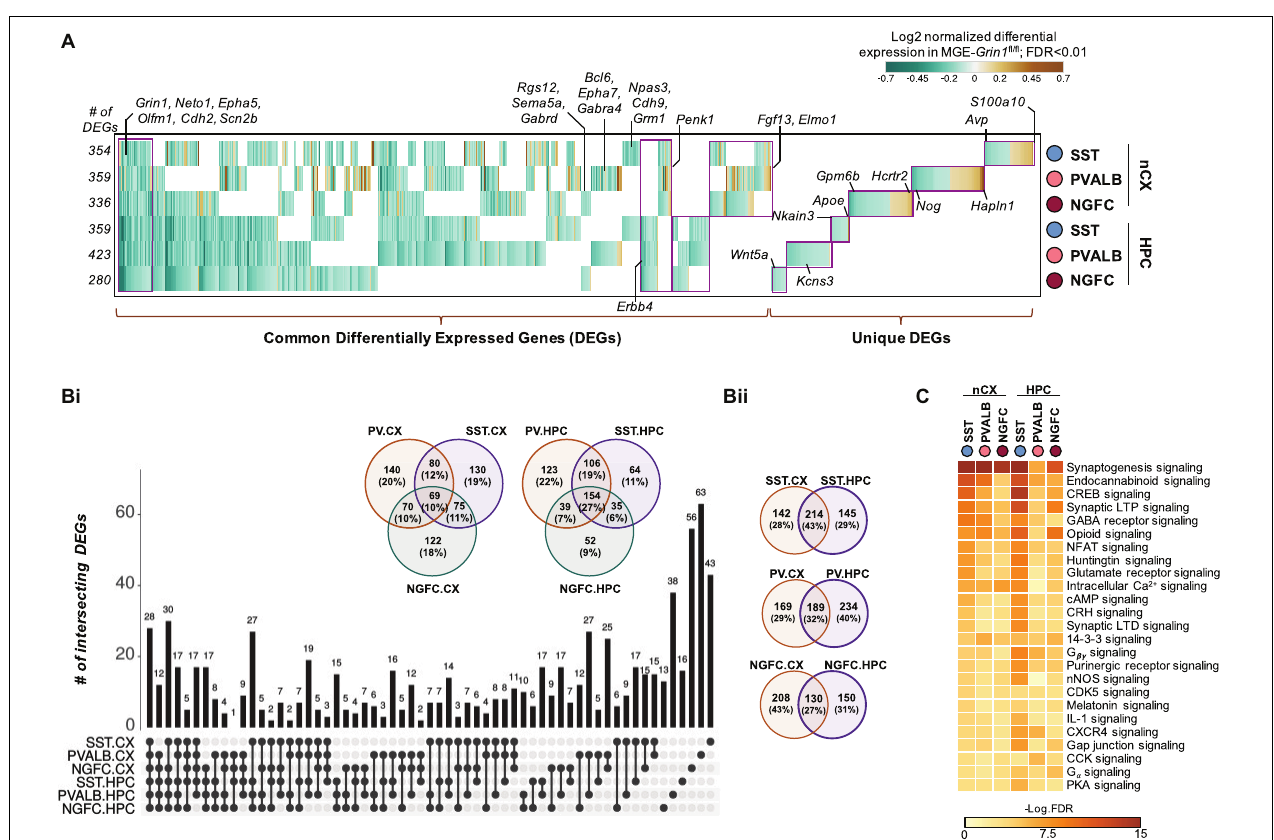
FIGURE 5 | Cell-autonomous transcriptional changes subsequent to MGE-specific developmental Grin1 -ablation. (A) Combined heatmap representing the 802 differentially expressed (DEGs) in the neocortical and hippocampal MGE-derived interneurons upon Grin1 -ablation, at a FDR < 0.01 and FC > 10%, as determined by MAST analysis (see details in section “Materials and Methods”). (Bi) UpSet plot and Venn-diagrams, respectively indicating the intersection and percentages of DEGs common across MGE subtypes from neocortex or hippocampus. (Bii) Venn-diagrams indicating the percentages of DEGs common within individual MGE subtypes from neocortex and hippocampus. (C) Ingenuity Pathway Analysis of significantly overrepresented molecular pathways in each MGE-subtype. FDR determined by Fisher’s Exact Test.